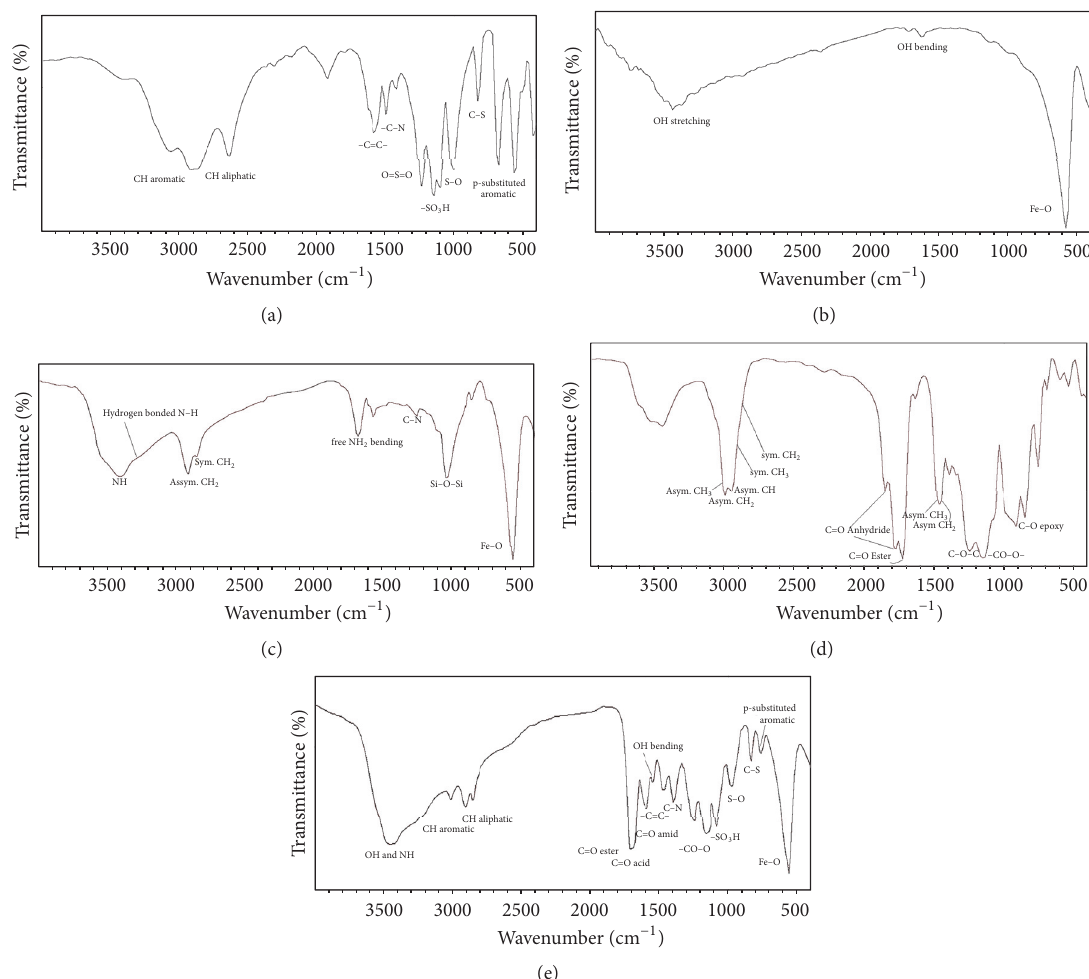
Figure 3: FT-IR spectra of ABSAc, bare Fe 3 O 4 , MNPs-NH 2 , PGMA-MAn, and PGMA-MAn/ABSAc@Fe 3 O 4